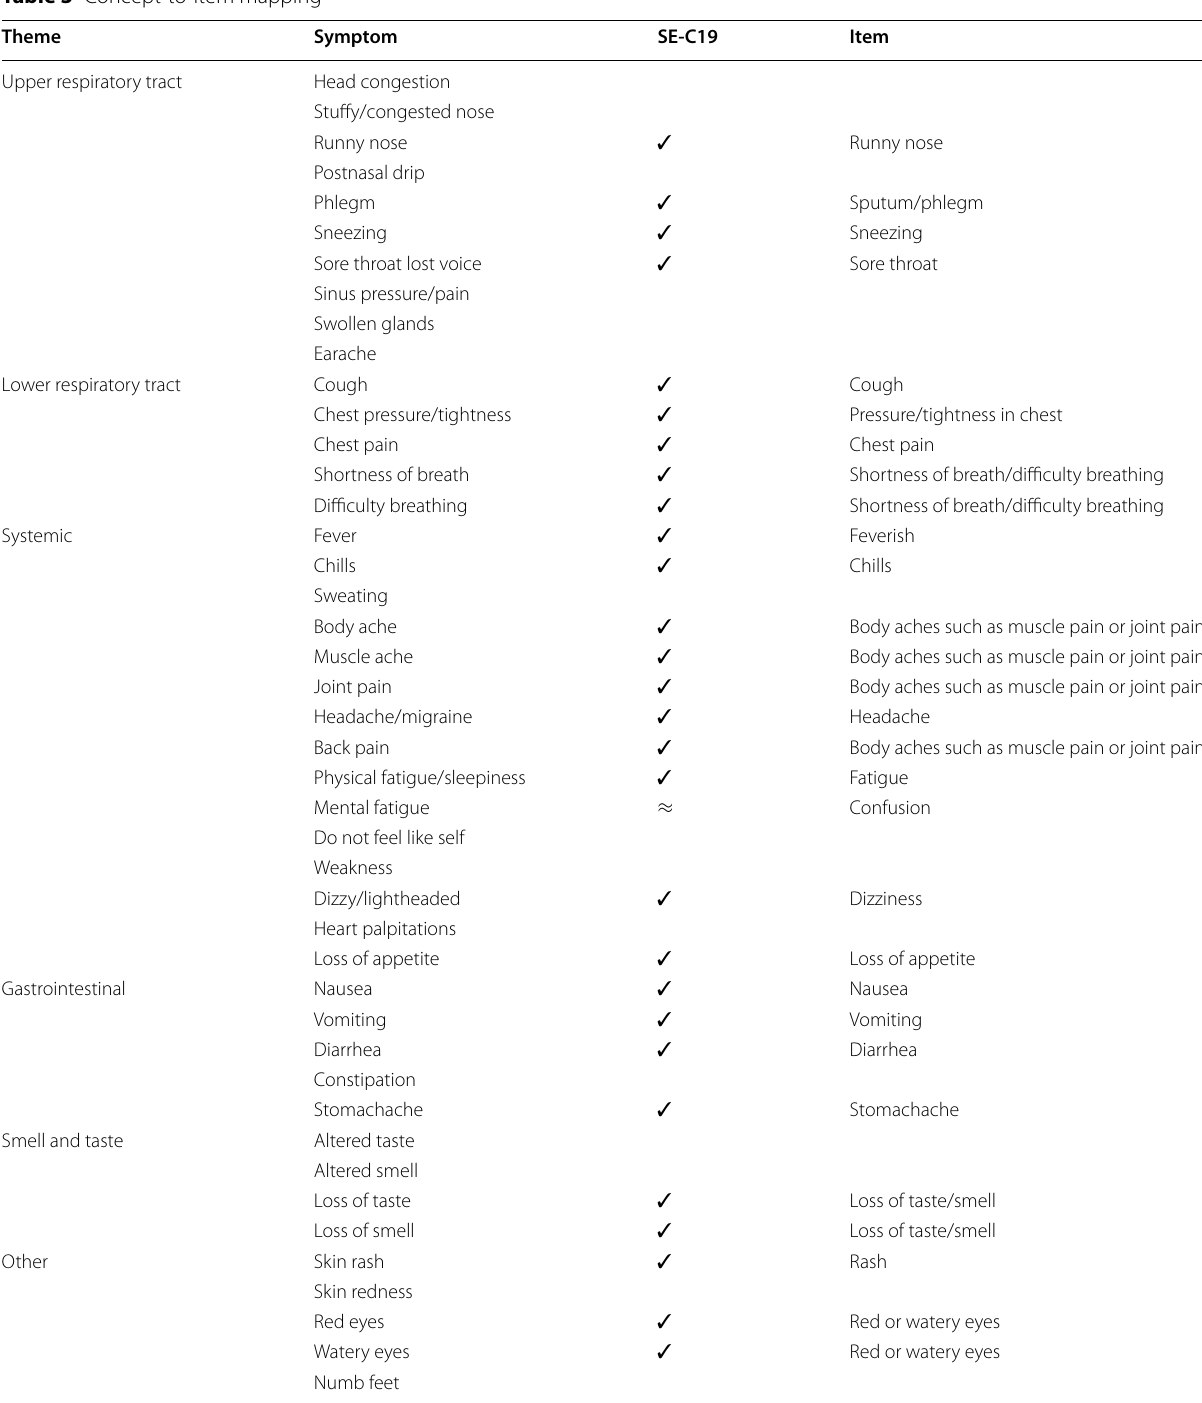
Table 3 Concept-to-item